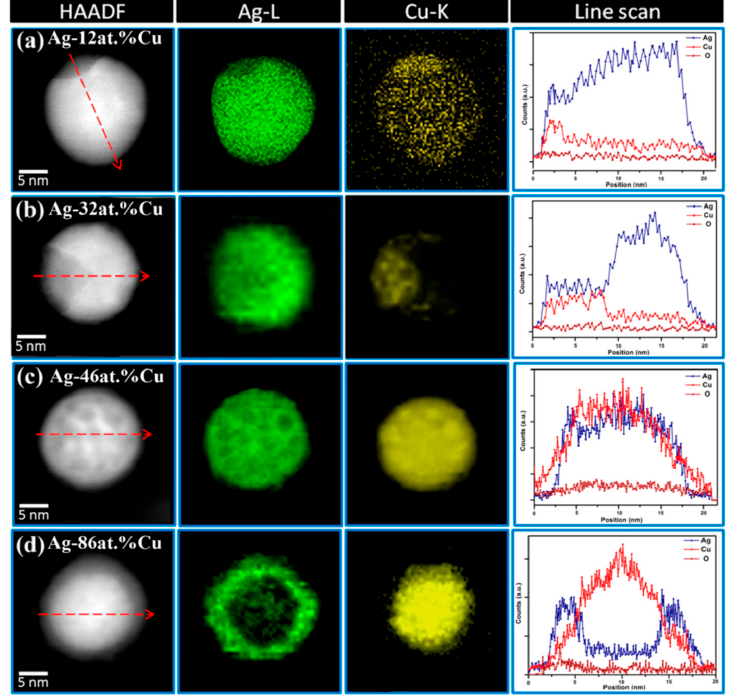
Figure 18. TEM-EDXS in high-angle annular dark field (HAADF) mode analysis of four different types of distribution of Ag and Cu in nanoalloy. Red arrow on HAADF image is the position and direction of line scan. Reproduced with permission from Reference [237]. Copyright 2014, American Chemical Society.